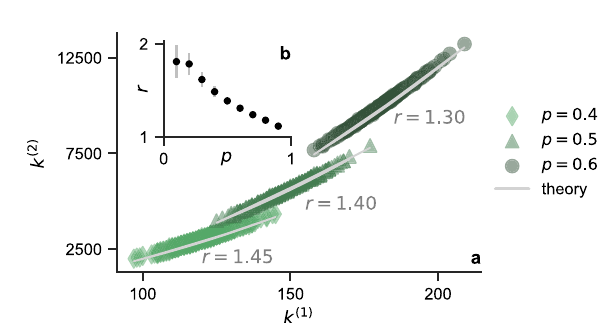
Fig. 2 | Pairwise and non-pairwise interactions synergize to optimize synchro- nization. a U-shaped curves are observed for λ 2 ( α ) corresponding to random hypergraphs over a wide range of p values. b Degree-based bound ∣ λ 2 ∣ ≤ n predicts the non-monotonic dependence on α . Each data point represents a 100- node random hypergraph and the three-body connection probability is set to p △ =0.05.